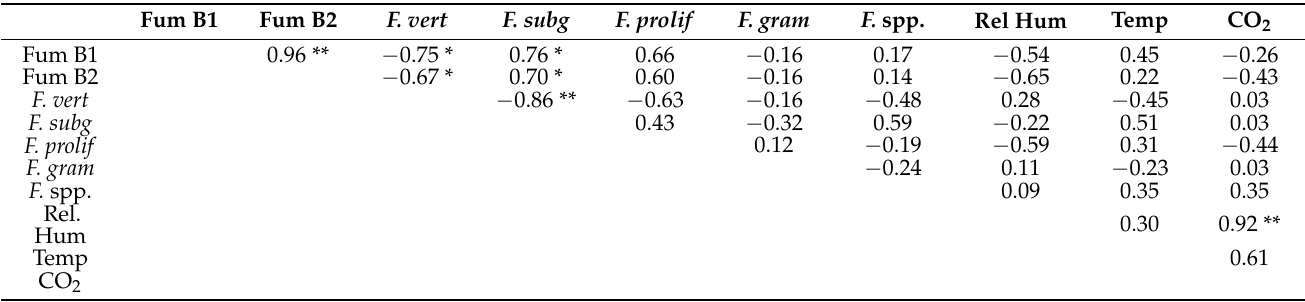
Table 3. Pearson correlation coefficients among fumonisin levels, Fusarium species incidence, and monitored parameters (relative humidity, temperature, and CO 2 ) from harvest and stored maize grains. Fum B1 Fum B2 F. vert F.